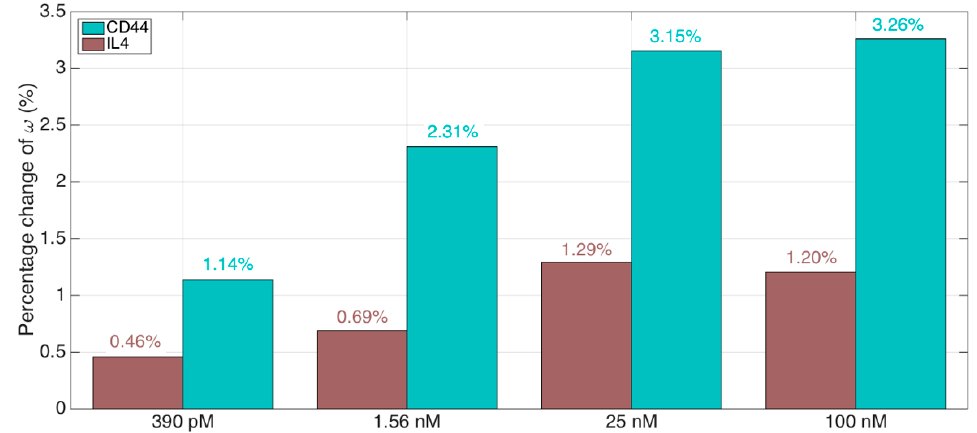
Figure 8. Evaluation of the specificity of the CD44 biosensor, using the KLT interrogation method. The chart shows the percentage change of the KLT output ω , calculated from the reference condition (6 pM, lowest concentration), for 4 different concentrations (390 pM, 1.56 nM, 25 nM, 100 nM) of the CD44 protein analyte compared to a control